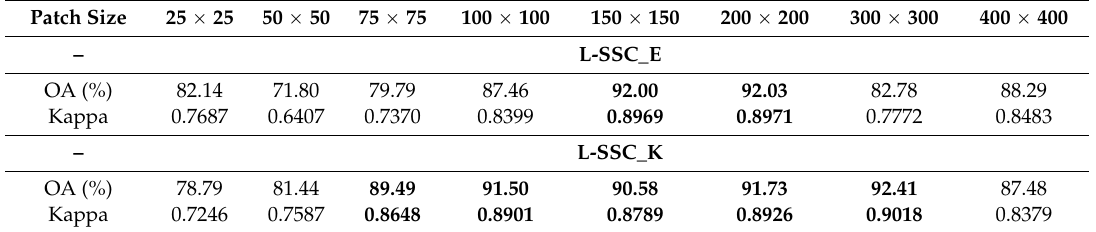
Table 7. The clustering accuracy of different patch sizes for the Wuhan TM image.